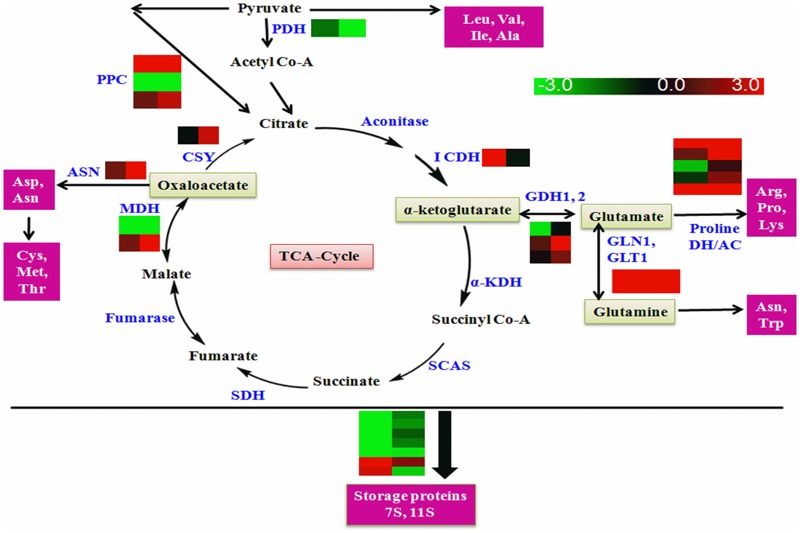
Schematic diagram of amino acid metabolism. PDH, pyruvate dedydrogenase; KDH, ketoglutarate dehydrogenase; ICDH, isocitrate dehydrogenase; SCAS, succinic Co-A synthase; PPC, pyruvate carboxylase; SDH, succinic dehydrogenase; MDH, malanate dehydogenase; CSY, citrate synthase GDH1, 2, glutamate dehydrogenase 1,2; GLN1, glutamine synthase; GLT1, glutamine synthetase, Proline DH, proline dehydrogenase; AC, arginine decarboxylase; ASN, asparagine synthase. Enzymes (Blue text); Amino acid precursors (Green box); Amino acids and proteins (pink box). The universal three letter code was used for amino acid representation. Right panel of heat map represents gene expression in GmLEC2a-transgenic roots, left panel represents expression in control (GUS) hairy toots.